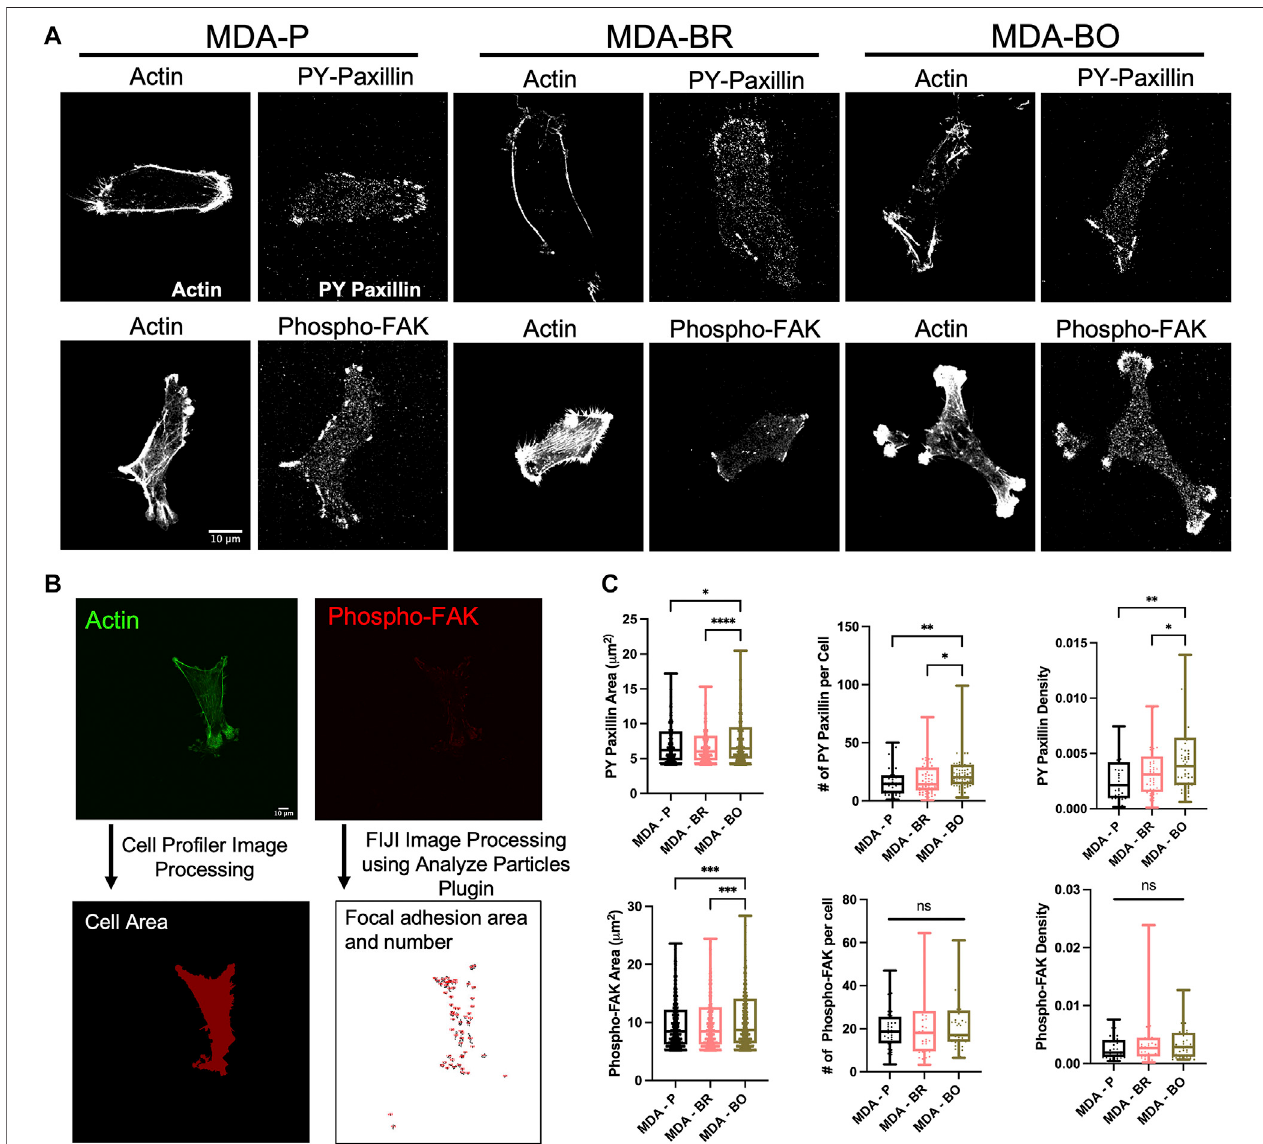
FIGURE 6 | Focal adhesions on Collagen I, and Collagen IV + Fibronectin. (A) Confocal images of PY-paxillin and/or Phospho-FAK and Actin on Collagen I or CollagenIV+Fibronectinsubstrates.Scalebarrepresents10 μ m.Imagesareadjustedforbestvisibility. (B) ImageprocessingprocedureusingFIJIandCellPro fi ler.Also shown are the area of focal adhesions (FAs), number of FAs per cell, and FA density (number of FAs normalized to cell area) for (C) PY-paxillin and Phospho-FAK on Collagen I. Box and whisker plots represent the minimum and maximum data points, the median, and the interquartile range. For FA area, each data point representstheareaofanindividualFA,andforFAnumberpercellorFAdensity,eachdatapointisrepresentativeofonecell.*indicates p < 0.05.**indicates p < 0.01.*** indicates p < 0.001.****indicates p < 0.0001.EachcolumnofdataisfromN > 53cellspooledfromatleast3independentexperiments.AROUTtestwasusedtoidentify outliers in the FA size and density data sets. The data with outliers excluded were used to perform the subsequent statistical analysis. The data was tested for normality using the D ’ Agostino and Pearson test. Data for number of phospho-FAK FAs per cell and PY-paxillin FA density on collagen I followed a normal distribution for some groups,andhenceaone-wayANOVAandmultiplecomparison ’ stestwereperformedtodeterminesigni fi cance.Forallothermeasurements,thedatawerenotnormally distributed, and hence a Kruskal Wallis test and a Dunn ’ s multiple comparison test were performed to determine signi fi cance.